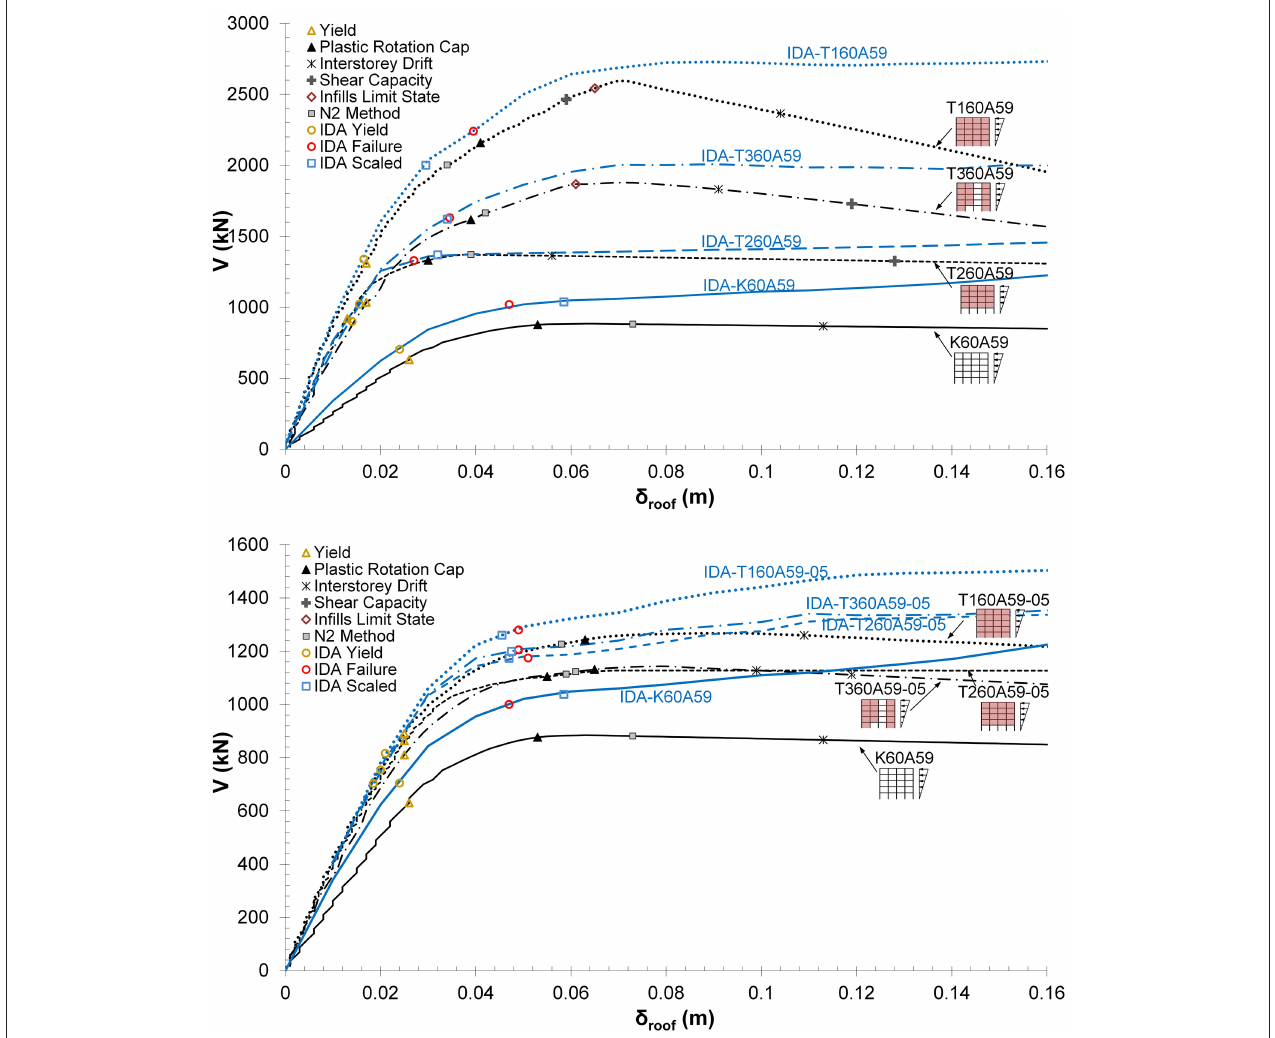
FIGURE 12 | SPO and median IDA predictions for the bare (K60A59) and infill (T160A59, T260A59 and T360A59) frames of the